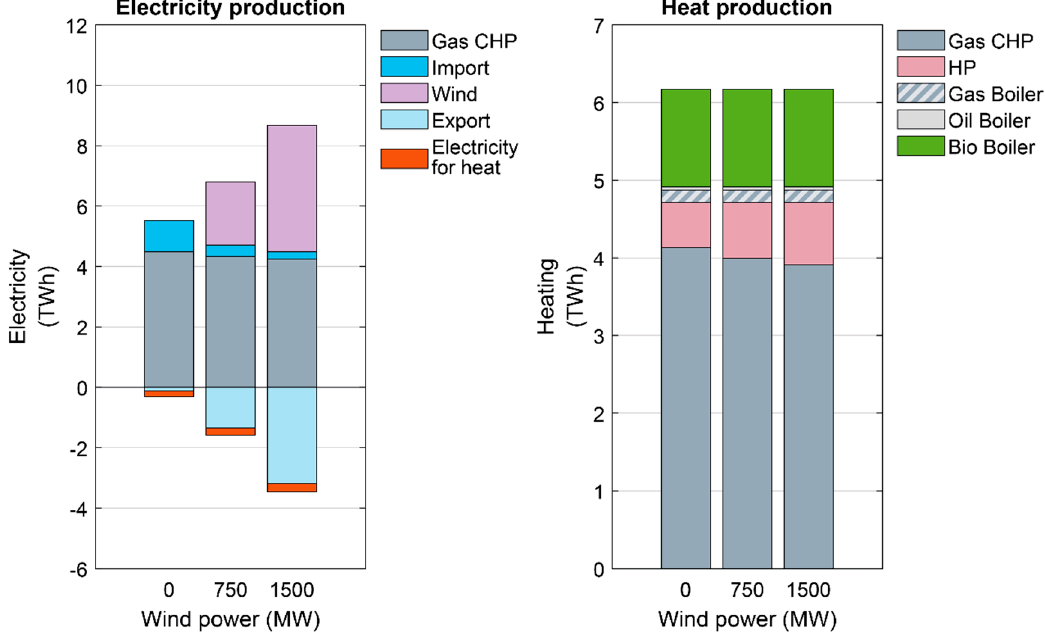
Figure 5. Power and heat production system of Helsinki in the BAU-2050 scenario for 2050.